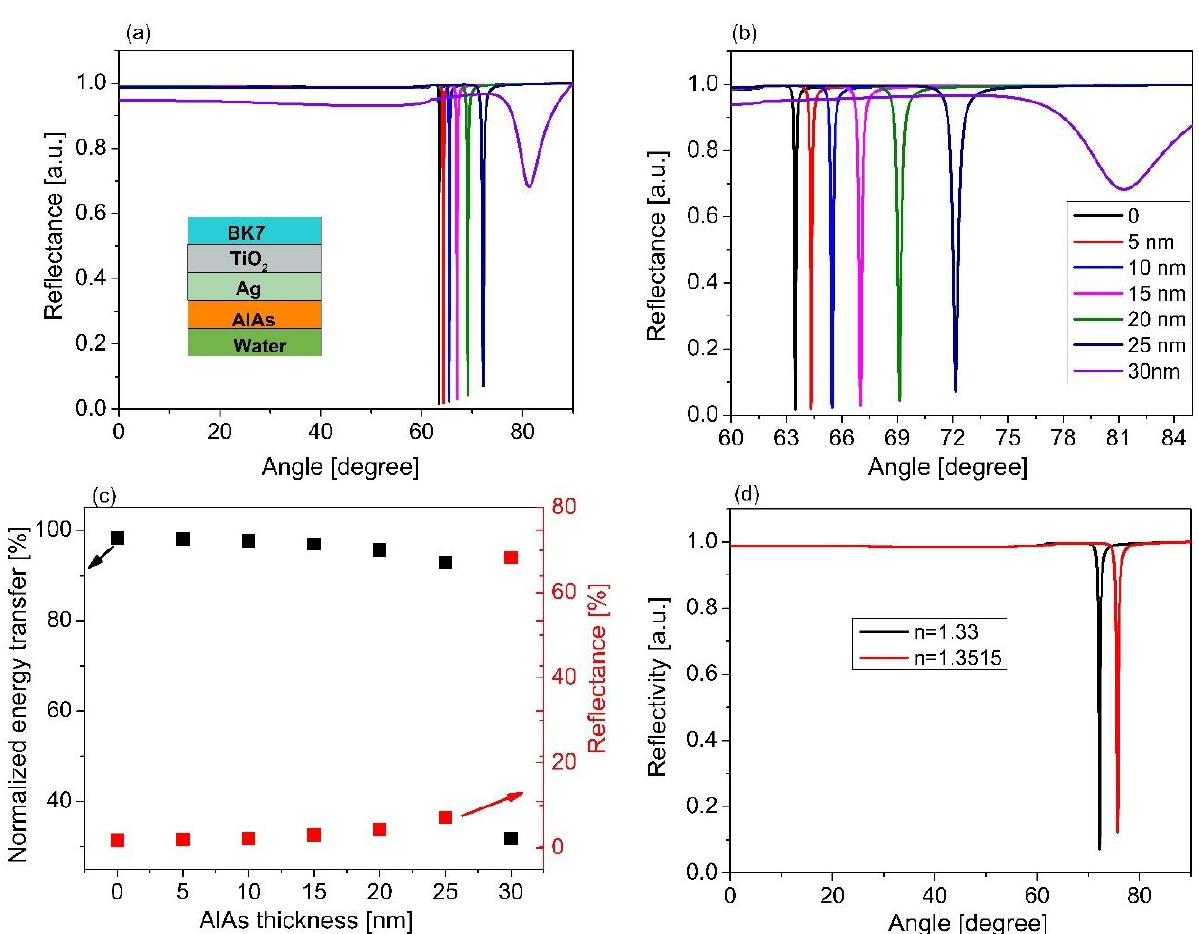
Figure 5. SPR spectra for varying thicknesses of AlAs based on the sensor structure of the BK7/TiO 2 /Ag/AlAs/sensing medium; ( b ) magnified view of ( a ); ( c ) the relationship between energy transfer and the AlAs thickness; ( d ) the change in resonance for different RI of the sensing medium based on the sensor structure of BK7/TiO 2 (140 nm)/Ag (60 nm)/AlAs (25 nm).